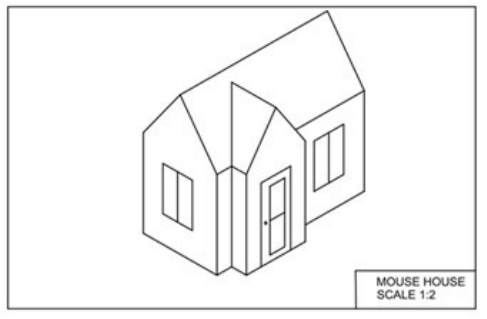
Figure 2: The three-dimensional drawing of the group’s mouse house